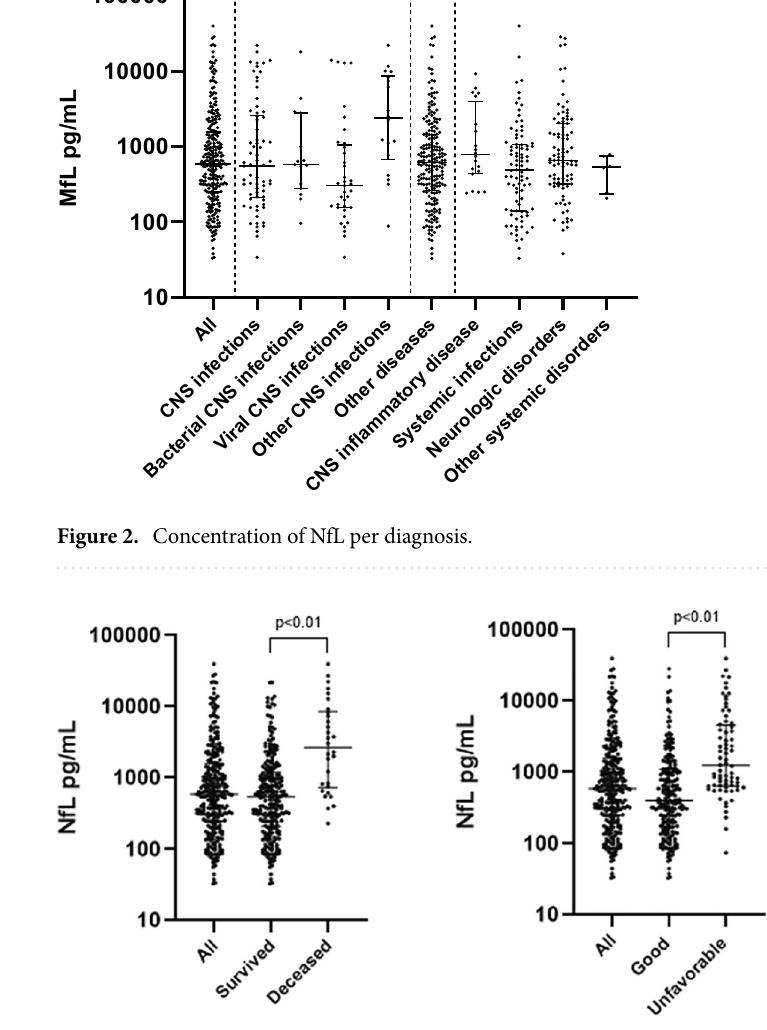
Figure 3. Concentration of NfL per